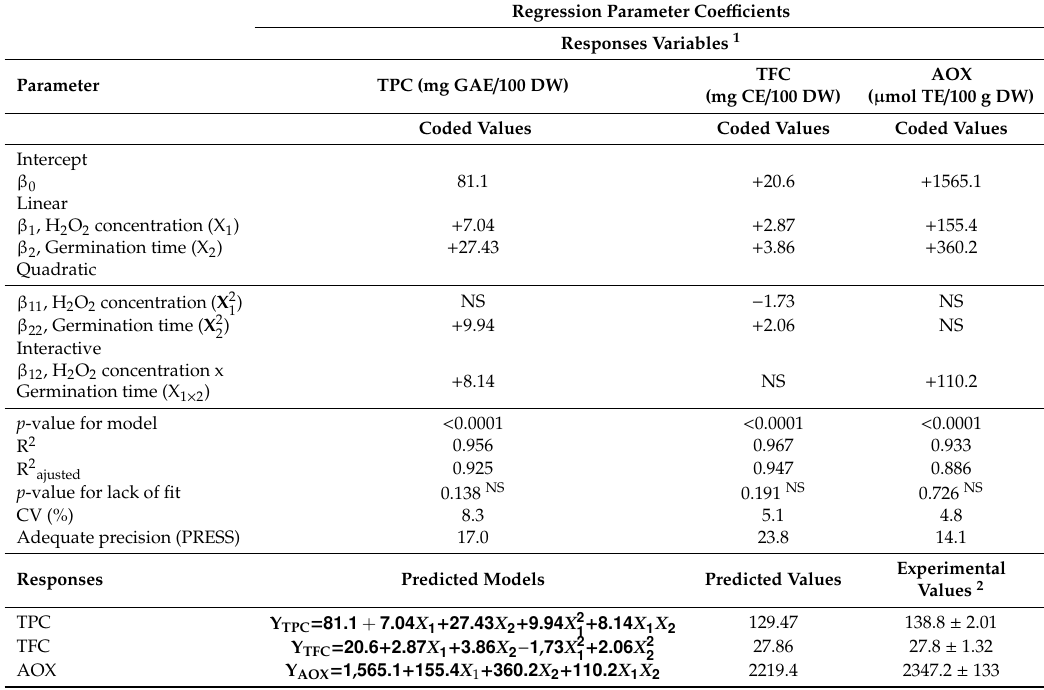
Table 2. Results of the regression analysis of predicted quadratic polynomial models for each of the response variables of chickpea